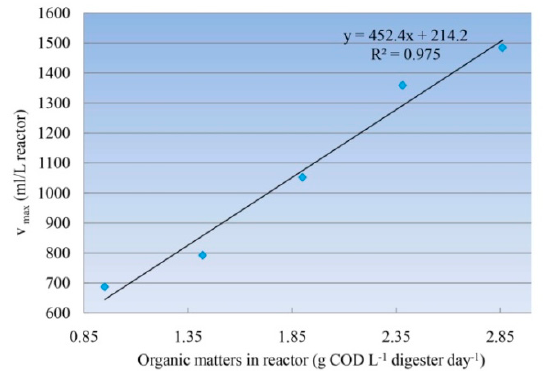
Energies 2020 , 13 , 818 Figure 6. Correlation between the amount of organic matter in the reactor and parameter V max .